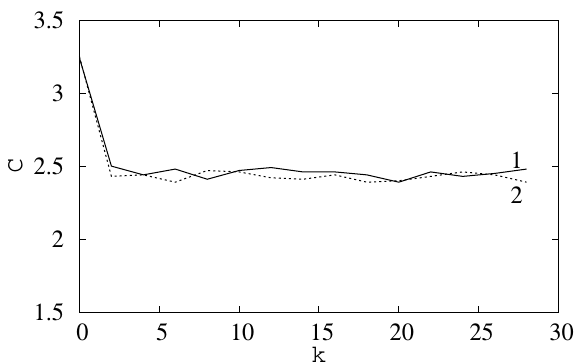
Fig. 8. Dependence of the correlation function C(k) on k , corre- sponding (1) to the map G n without noise and (2) with noise (92) for calculations over 2000